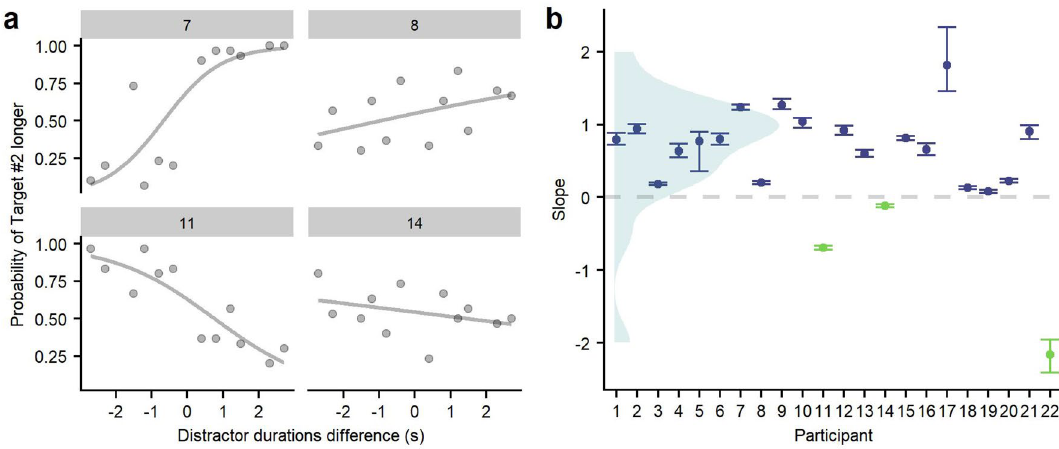
Figure 5. ( a ) Psychometric functions from a sample of four participants (7, 8, 11 and 14) with high (left column) and low (right column) slopes as well as positive (upper row) and negative (lower row) values. ( b ) Distribution and slope values of the psychometric curve of each participant in the Distractors condition. Points represent the slope estimate and brackets represent 95% confidence